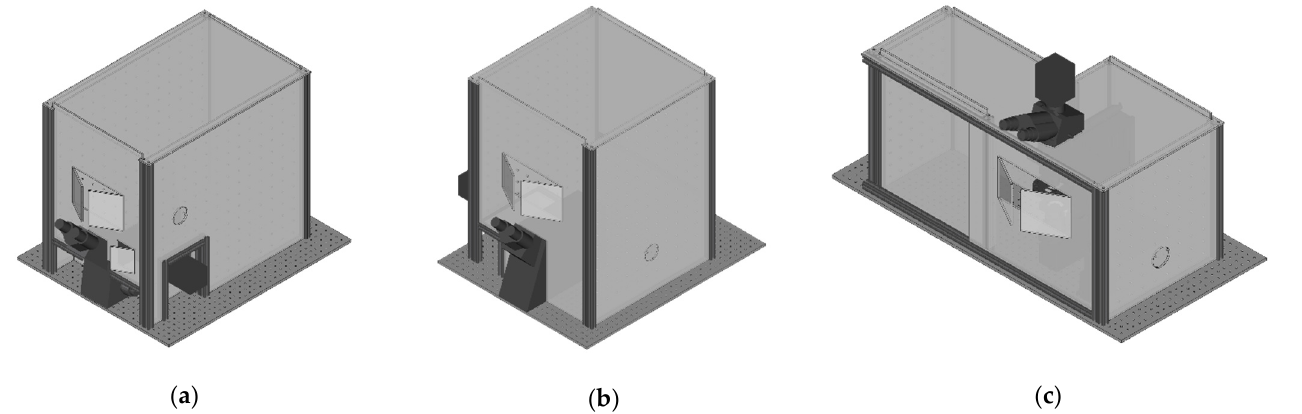
Figure 1. Inverted and upright enclosures. Inverted microscope enclosure designed around an ( a ) IX-81 frame (Olympus Scientific Solutions America, Waltham, MA 02453 USA) and an ( b ) Olympus IX-83 frame. ( c ) Upright microscope enclosure designed around a Thorlabs Cerna system (Thorlabs Inc., Newton, NJ, USA).